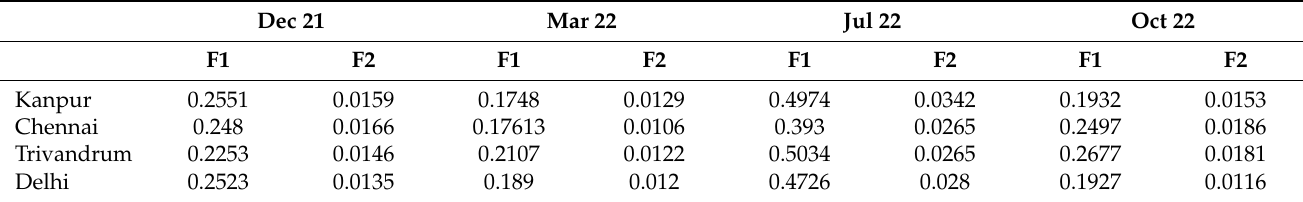
Table 4. Predicted F1 and F2